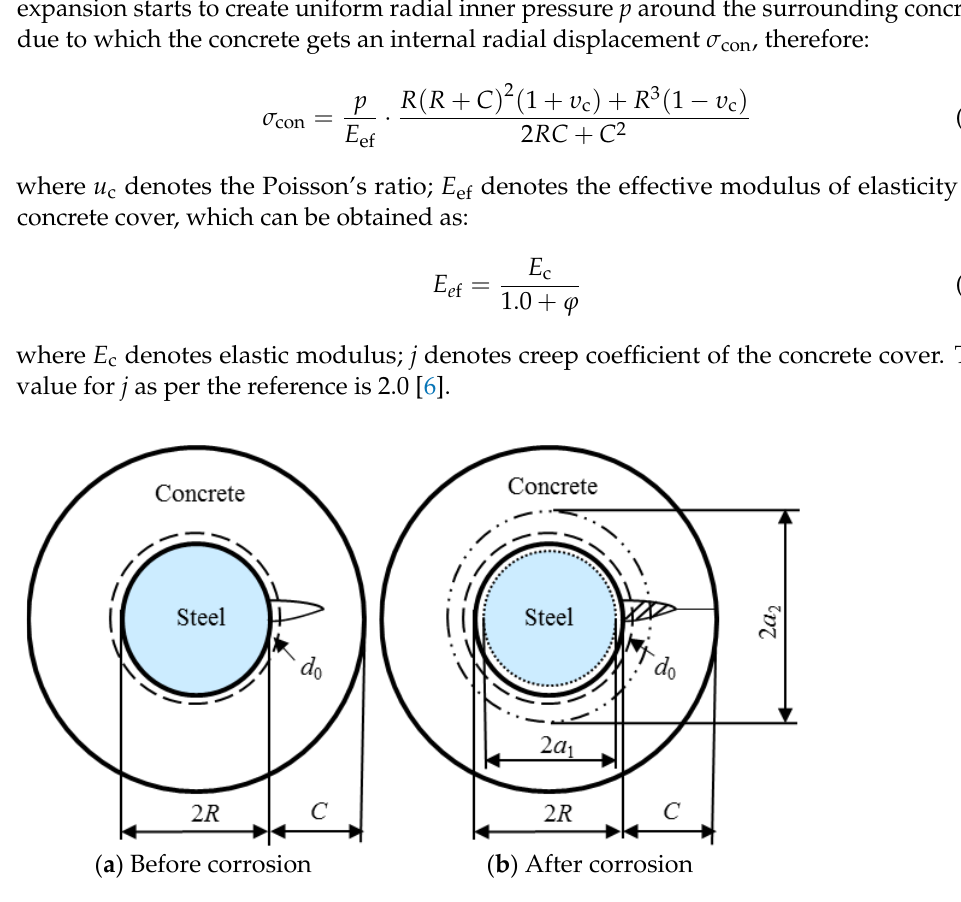
Figure 2. Calculation model of corrosion rate: ( a ) before corrosion; ( b ) after corrosion; R —original radius of steel bar; a 1 —radius of steel bar after corrosion; a 2 —combined radius of un-corroded steel plus free-expansive corrosion product; d 0 —the thickness of porous zone.